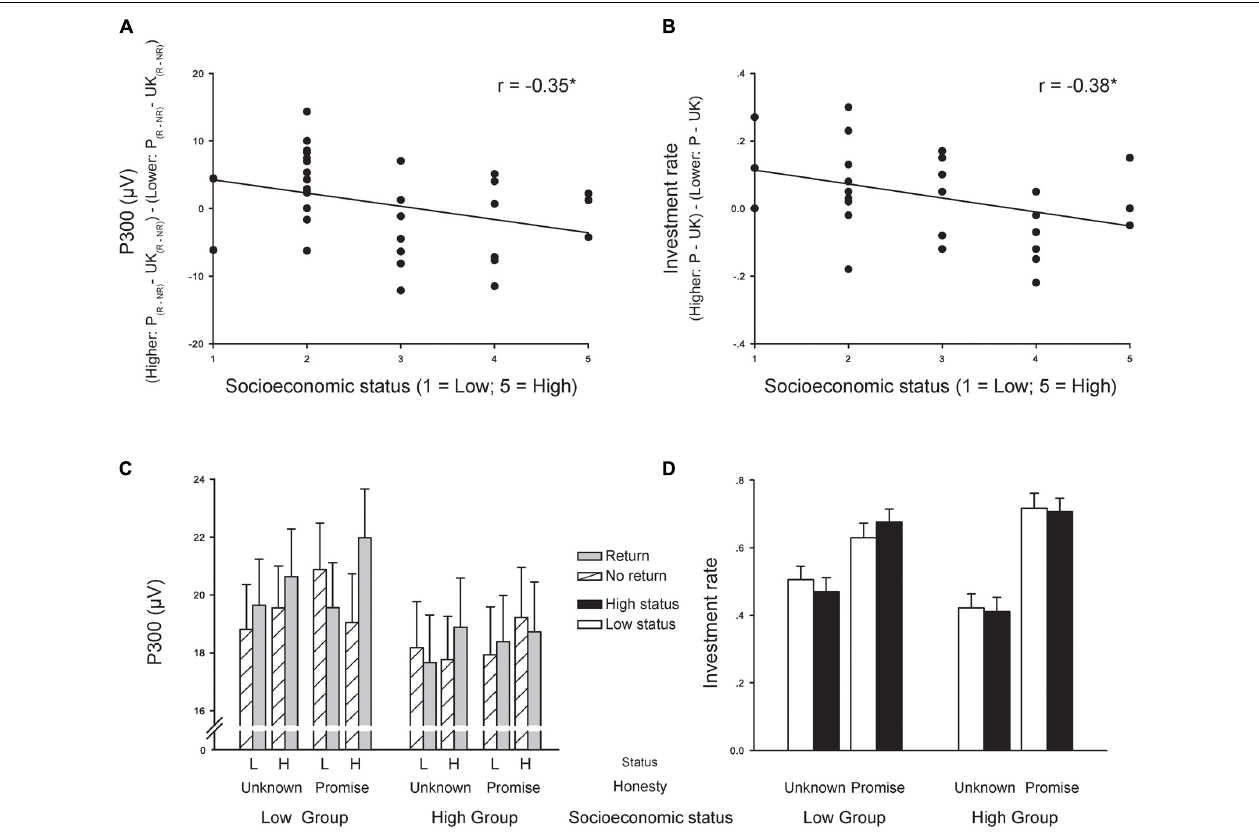
FIGURE 5 | Effects of Objective SES (i.e., parents’ highest achieved level of education) on TG behavior and ERP response (P300 peak amplitudes in the medial central cluster time-locked to the TG feedback). (A) Correlation between Objective SES and the interaction between partner social status, promise, and return on P300 peak amplitudes. (B) Correlation between Objective SES and the interaction between partner social status and promise on investment behavior in TG. (C) Objective SES split-group analysis of P300 peak amplitudes plotted as a function of partner social status, promise, and return. (D) Objective SES split-group analysis of investment behavior plotted as a function of partner social status and promise. Groups based on median split: Low Objective SES group ( n = 17) and High Objective SES group ( n = 16). “P” indicates Promise; “UK” indicates Unknown; “L” indicates Lower Status Trustee; “H” indicates Higher Status